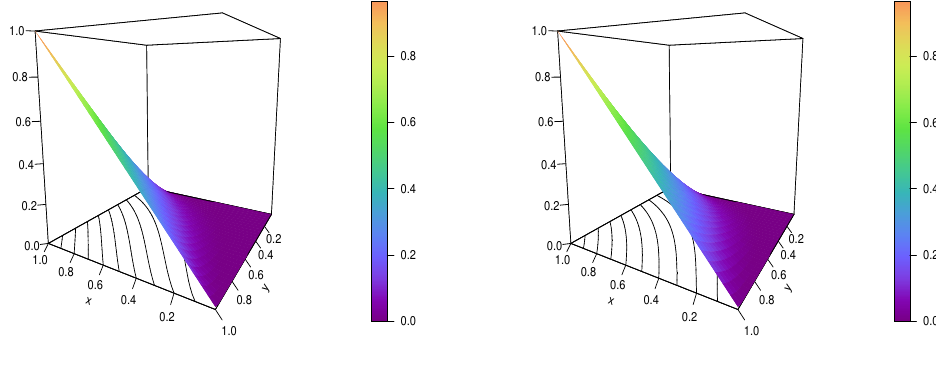
Figure 3. Plots of the IP copula for α = 1 and β = 1 ( left ) and β = 1/2 ( right